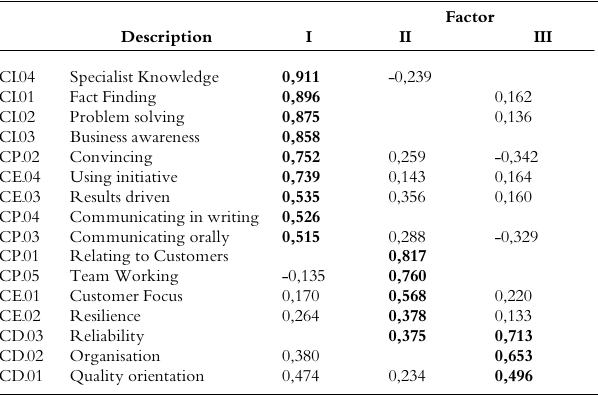
TABLE 2 ROTATED FACTORMATRIXOF THE 3 FACTORSOF